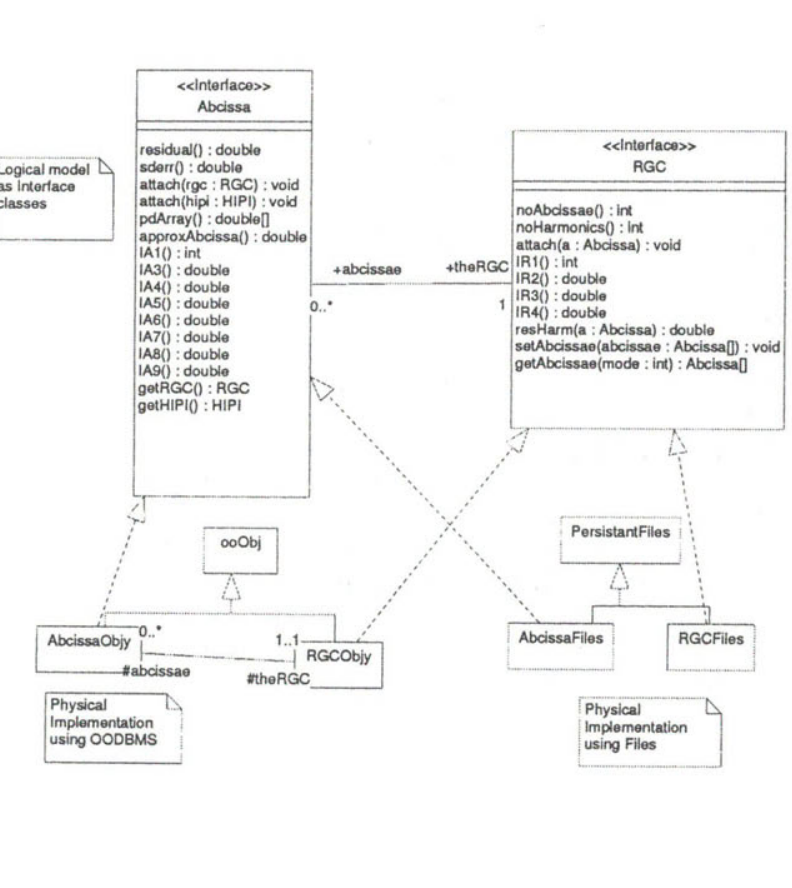
Fig. 3. Interfaces and